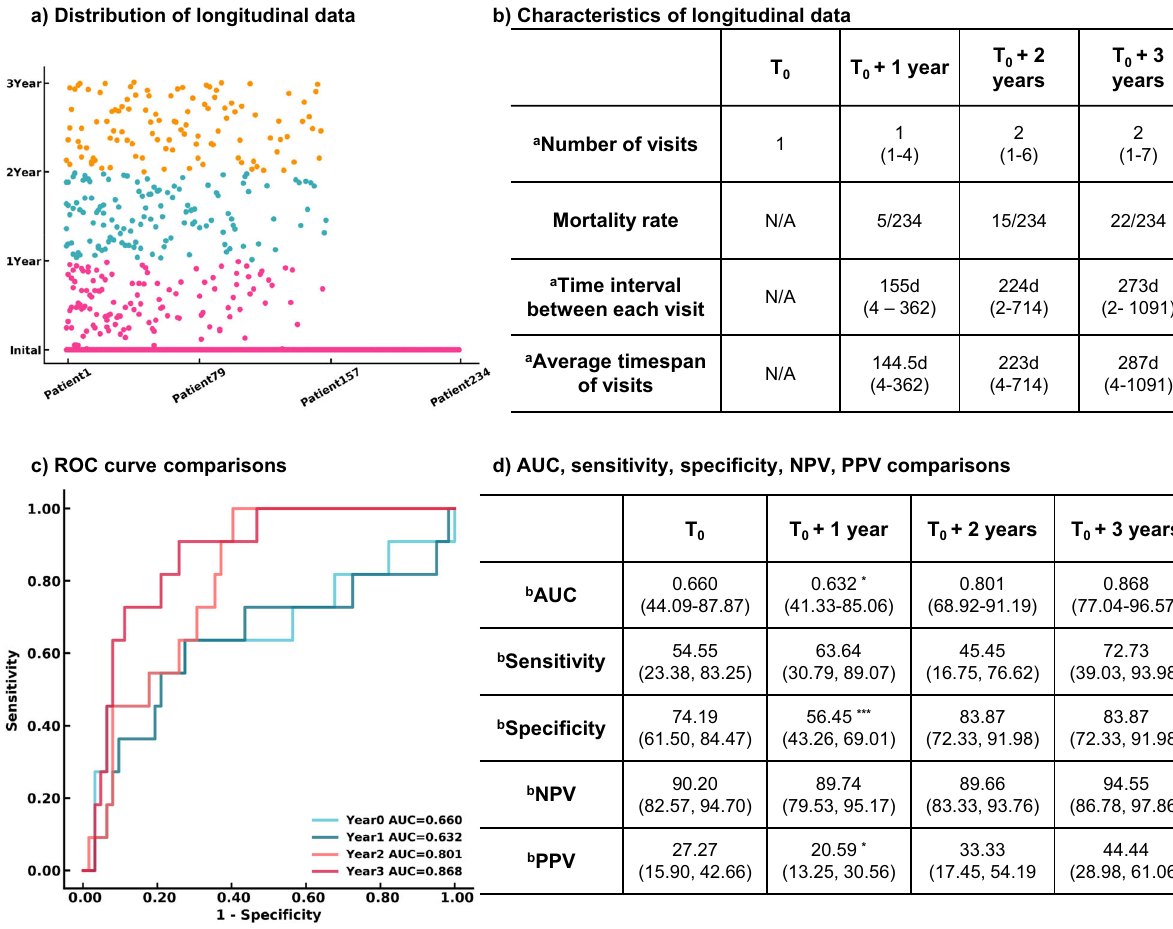
Fig.4|ResultsoftheAImodelstopredictthe3-yearsurvivalrate.a Distribution of longitudinal visits from each patient. Each visit of 234 patients included in the survival rate study was presented. b Characteristics of longitudinal data. c ROC curves of 3-yearsurvival rate prediction atdifferent endpoints. d Performance and